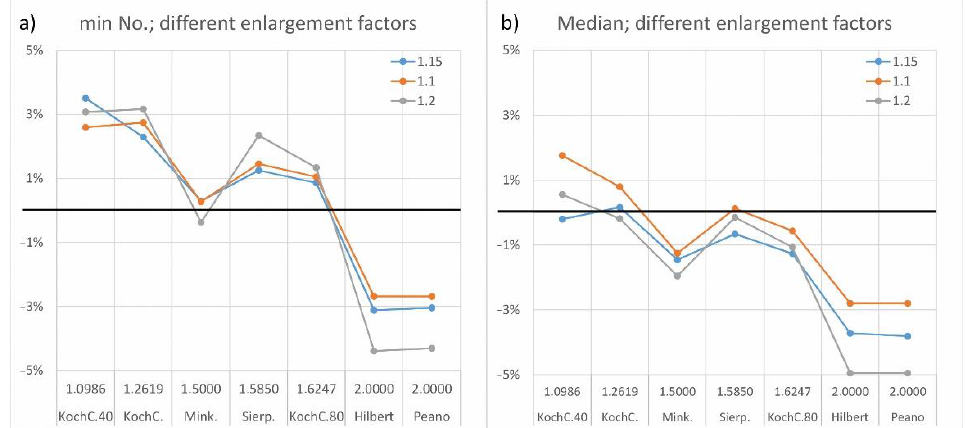
Figure 8. Results with pre-defined settings showing the difference for 1.1, 1.15 and 1.2% enlargement factor, with ( a ) showing the medians and ( b ) showing the results for only smallest number of covering boxes.